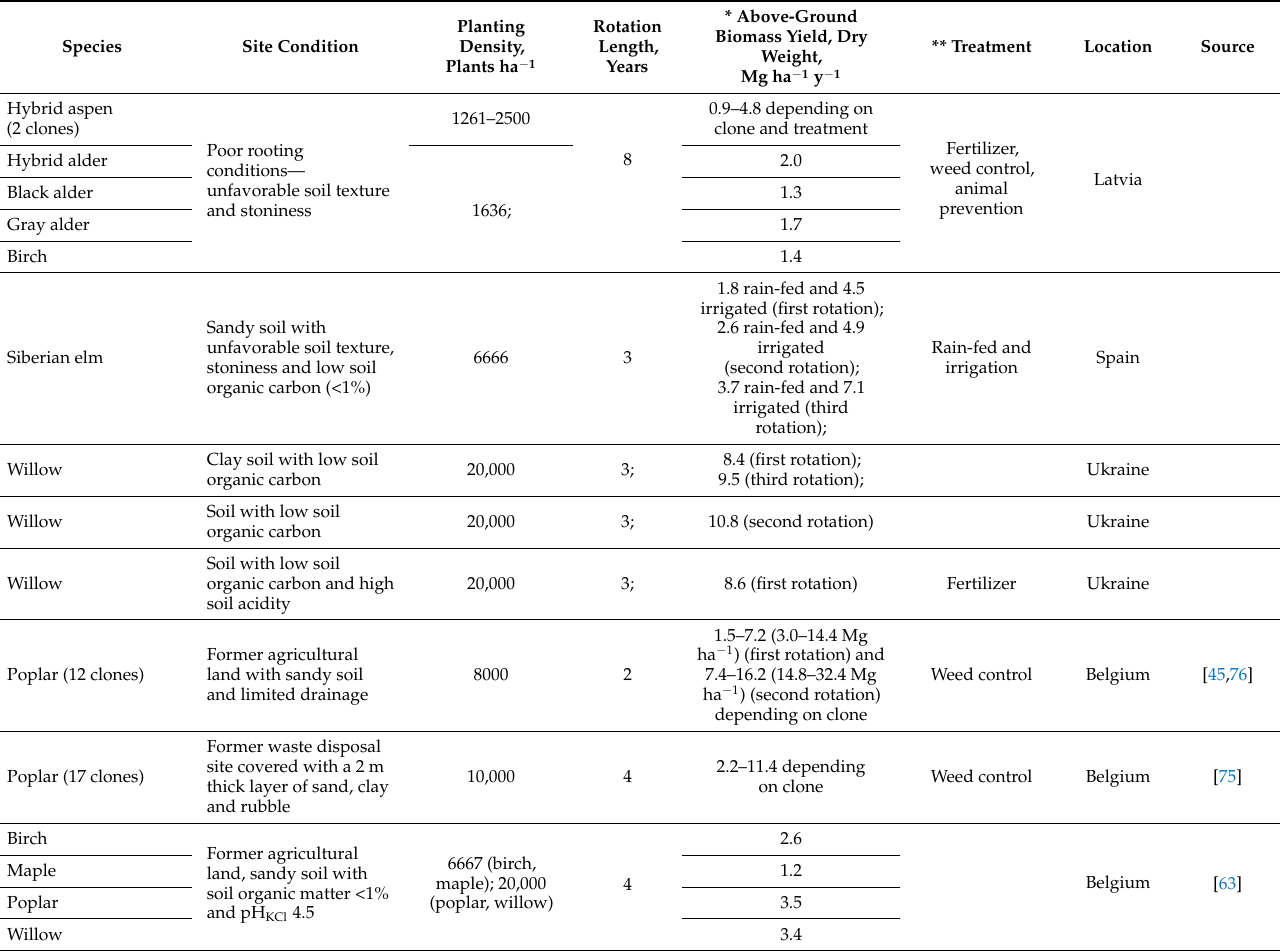
Figure A3. Average monthly climatic conditions of the study site located in Ukraine during the study period 2011–2019. Table A4. Results of woody crop above-ground biomass yield on marginal land based on research done in